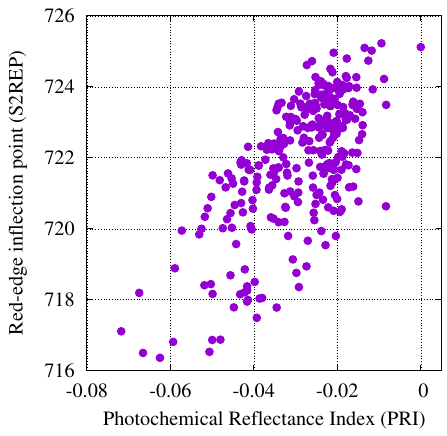
Figure 6. The relationship between Photochemical Reflectance Index (PRI) and red-edge inflection point calculated by linear four-point interpolation approach (S2REP) ( ρ = 0.60, p <